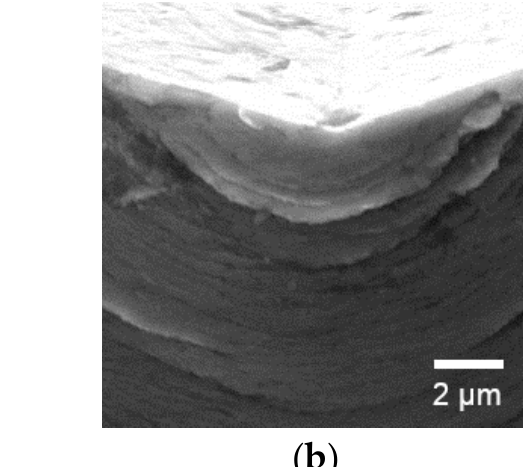
Figure 7. Bonded indentation of BMG Vit105 after HPT n = 1: ( a ) deformation area on the side surface area near the indent (SEM); ( b ) same, enlarged.